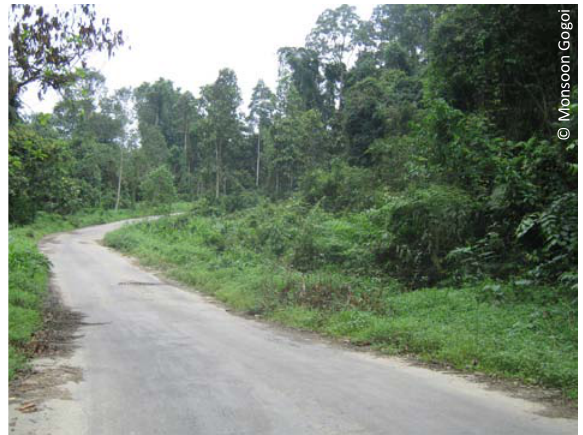
Image 2. Deomali road passing through Jeypore Reserve